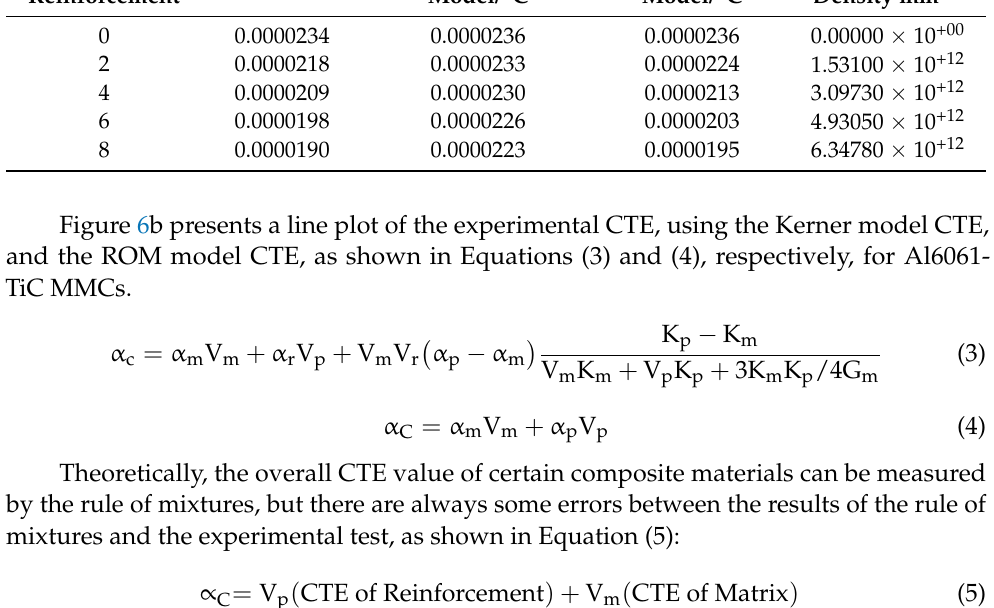
Table 3. CTE and dislocation density values of Al601-TiC MMCs. wt.% of